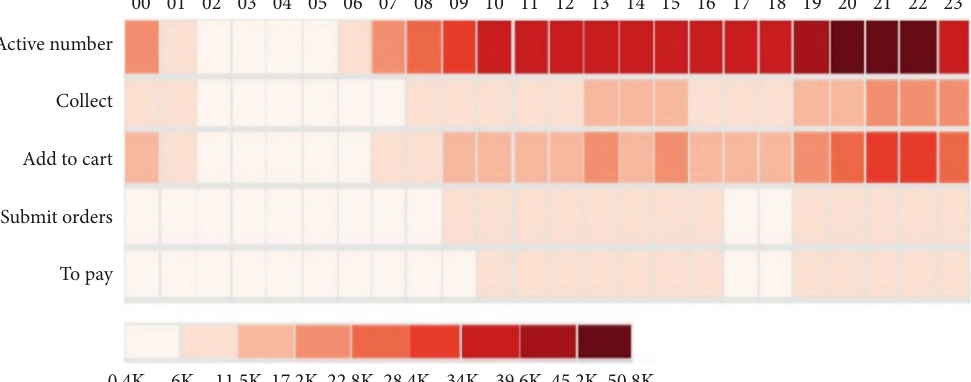
Figure 14: Time-sharing partition diagram of user behavior.